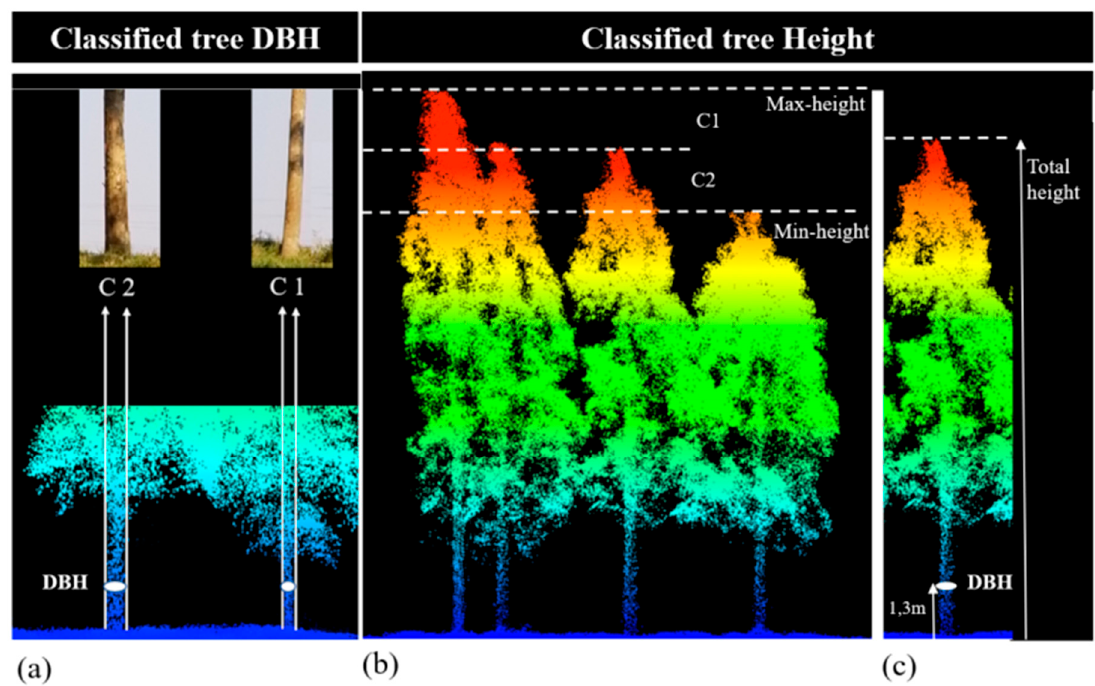
Figure 4. Classes used in this work. ( a) Classes used for tree dbh C1 and C2; ( b ) Classes used for tree height C1 and C2, minimum-height and maximum-height; ( c ) Total height tree.